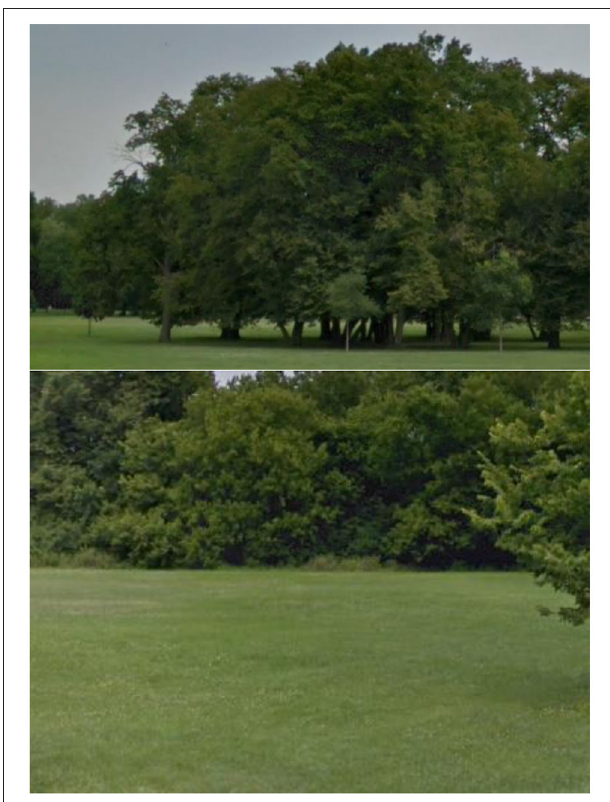
FIGURE 2 | Both images show the difference between trees with and without an understory. The top image shows a wooded area with no understory. The bottom image shows a wooded area with an understory.